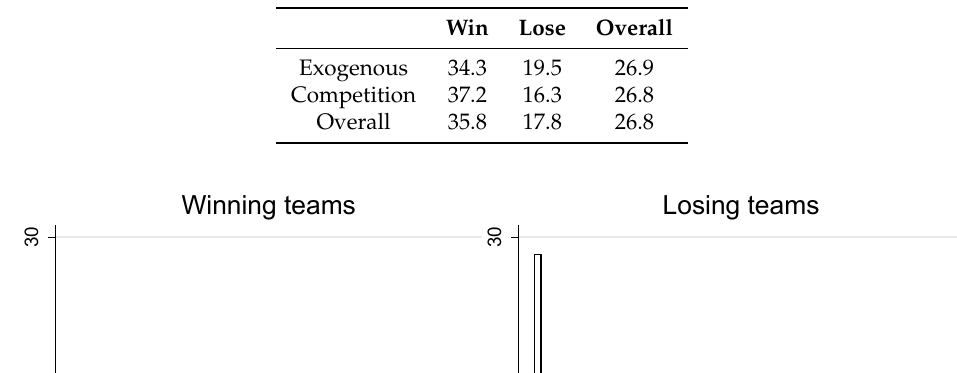
Table 2. Average individual contribution.